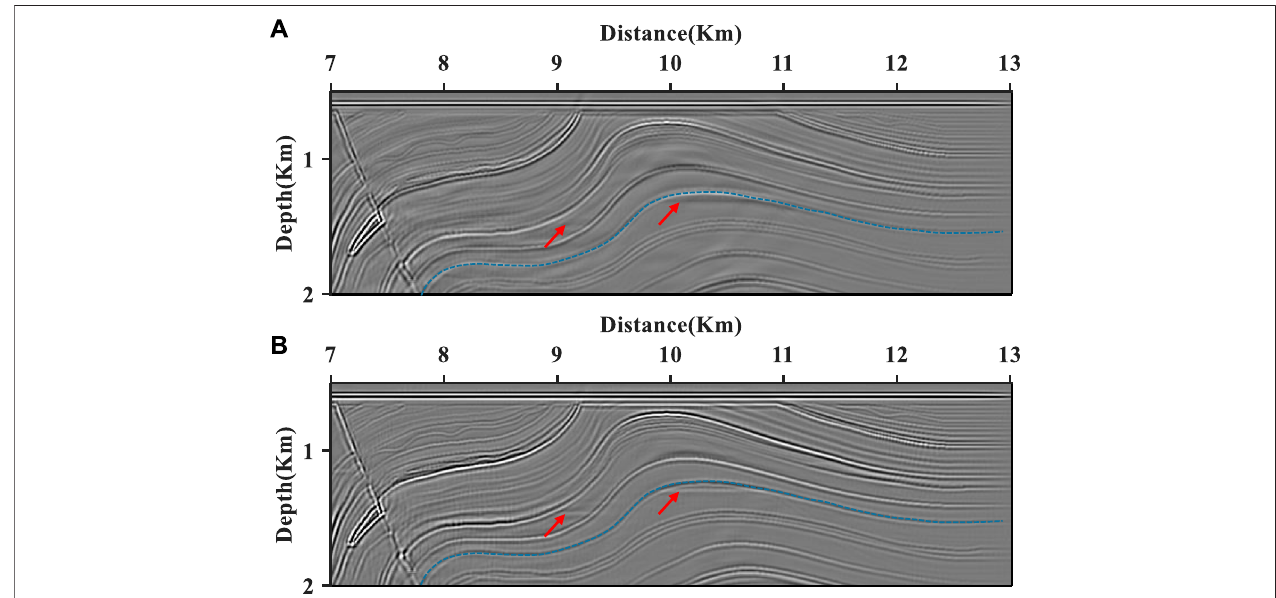
FIGURE18| The partialenlargementsofPPimagesoftheMarmousi2modelbythescalar imagingconditionwiththeLaplace fi lter(PanelA)and withthe pseudo- Laplace fi lter (Panel B). The polarity of the event (such as events marked by the blue curve) in Panel B is more continuous than that in Panel A. Furthermore, clearer interfacesandlessdisturbanceoftheoilandgasreservoirsatsub-cover(markedbytheredarrow),indicatedbythepartialenlargementsoftheelasticMarmousi2model in Figure 17B , are located in Panel B.